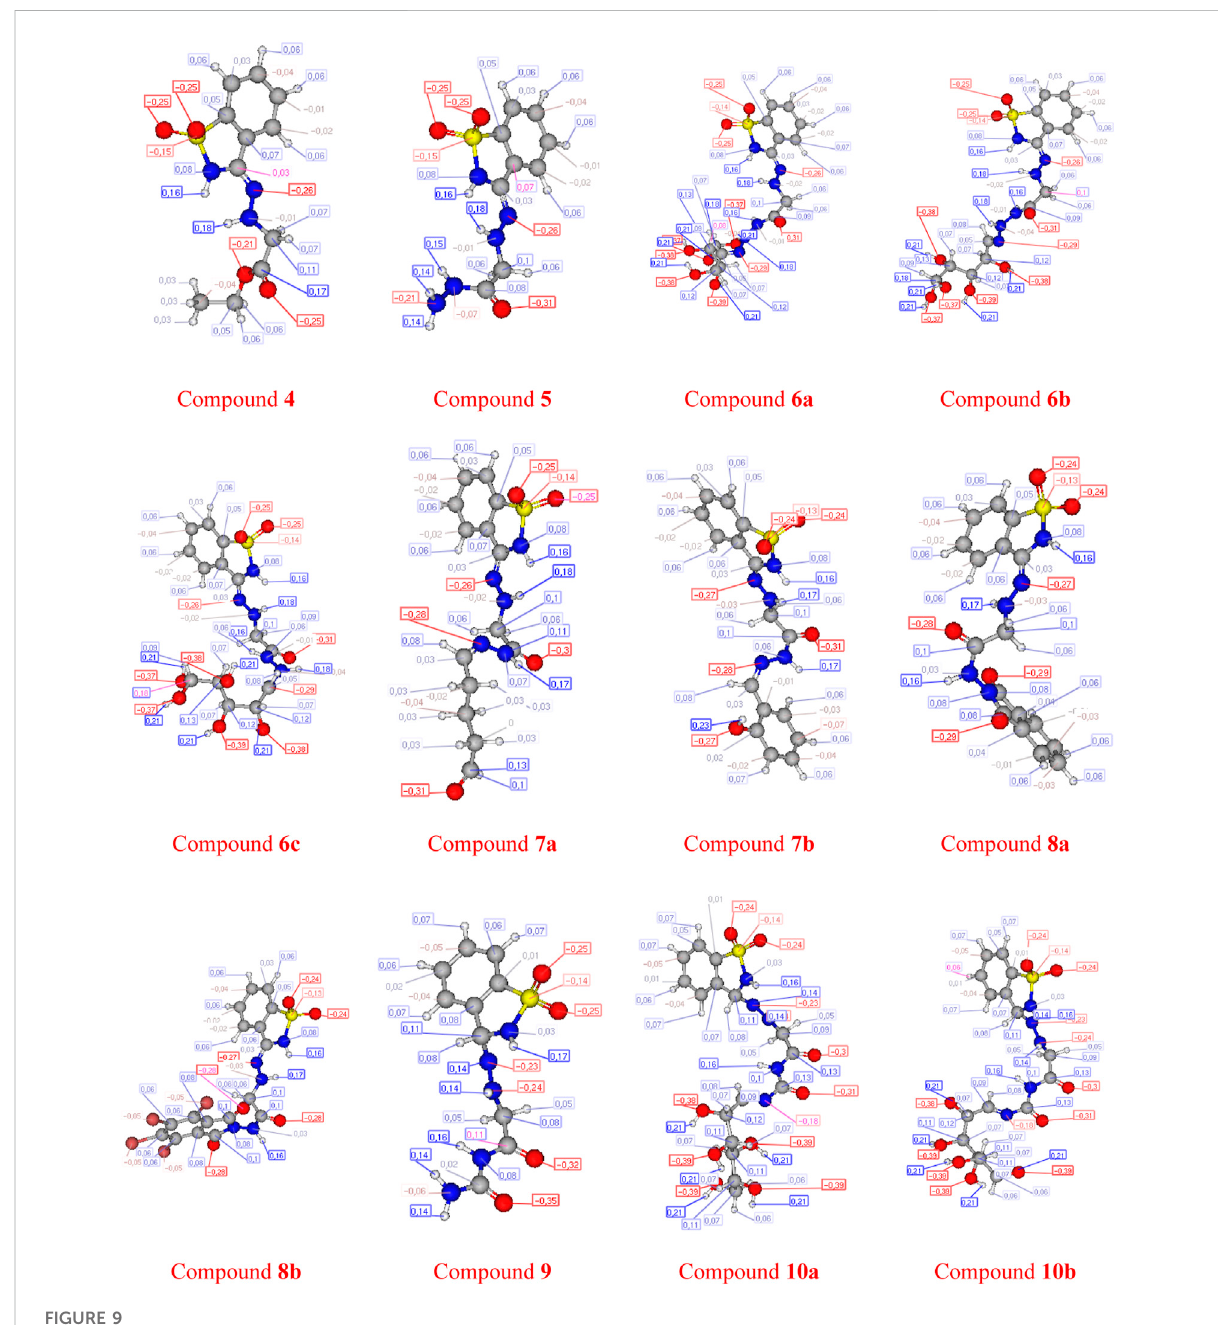
FIGURE 9 Atomic charge calculation of